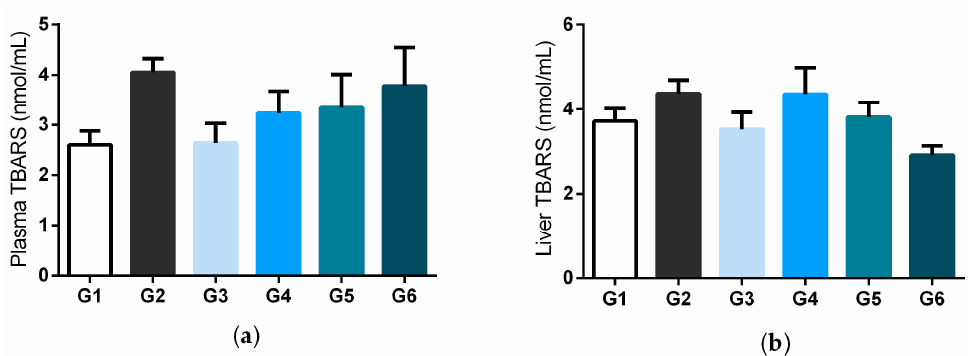
Figure 3. Plasma ( a ) and liver ( b ) concentrations of thiobarbituric acid reactive substances (TBARS) in STZ-induced diabetic rats treated with bacuri seed butter (BSB). Legend: normal control (G1); diabetic control (STZ) (G2); STZ + BSB 25 mg/kg (G3); STZ + BSB 50 mg/kg (G4); STZ + BSB 100 mg/kg (G5); STZ + insulin NPH 6 UI/day (G6).